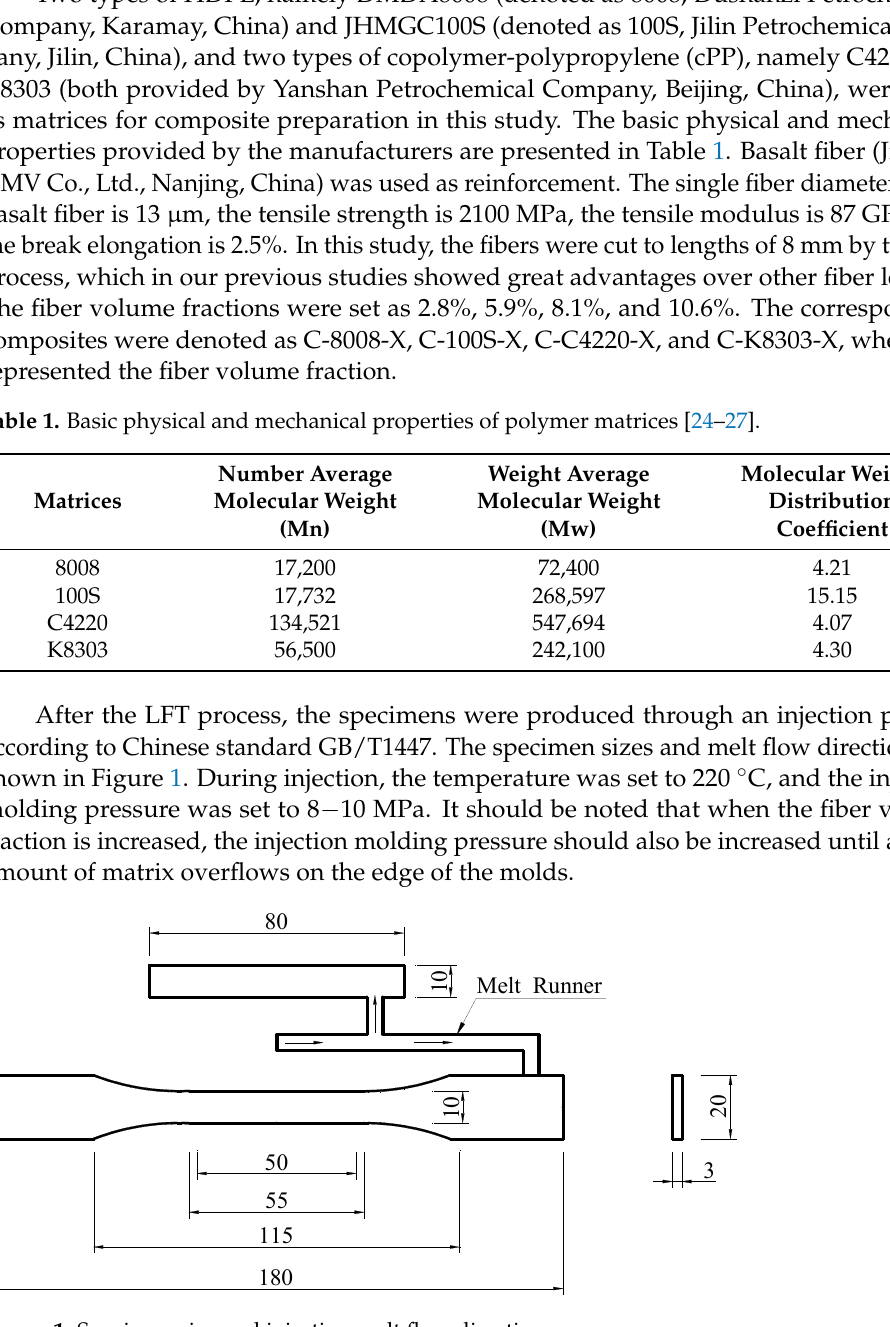
Figure 1. Specimen size and injection melt flow direction.